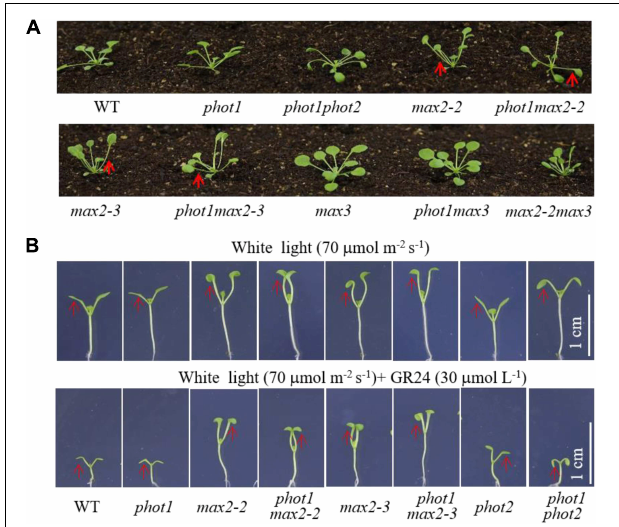
FIGURE 4 | Leaf flattening and positioning and hypocotyl elongation of WT and mutant plants. (A) Leaf flattening and positioning in the WT and mutants grown under 70 µ mol m − 2 s − 1 white light for about 4 weeks. Red arrows indicate the different leaf positioning phenotypes between the single and double mutants. (B) Hypocotyl elongation of 7-day-old WT and mutant plants under 70 µ mol m − 2 s − 1 white light, with or without 30 µ mol L − 1 GR24. Scale bars represent 1